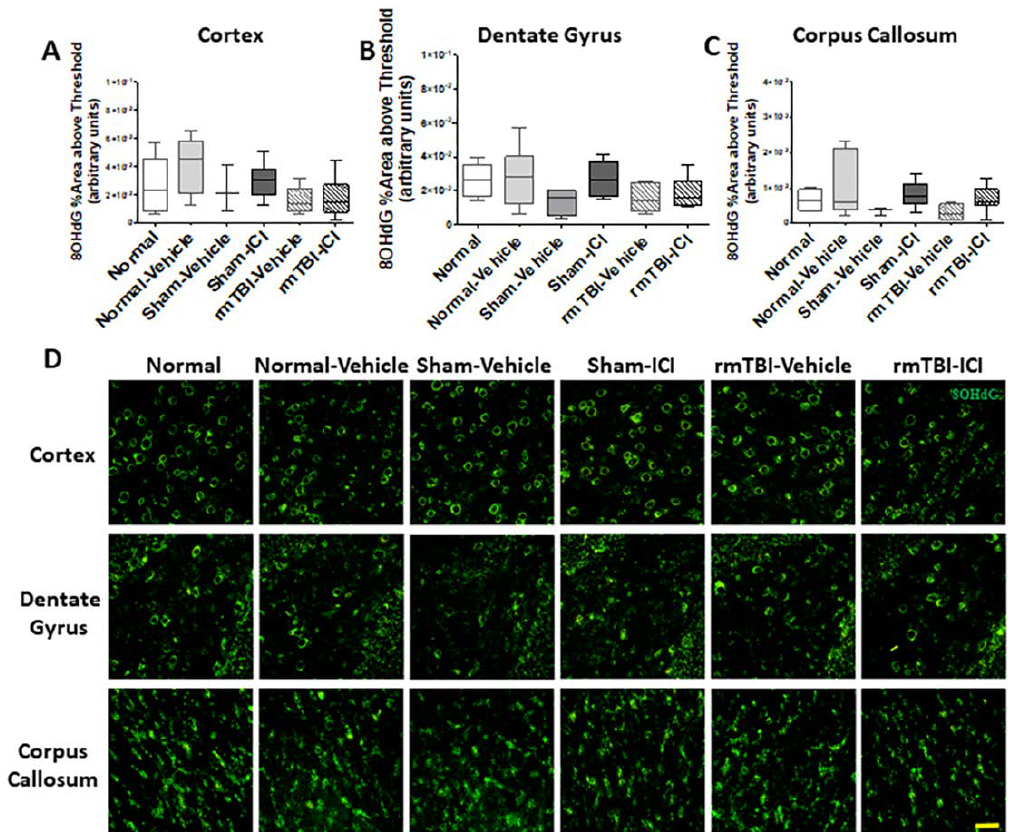
Figure 4. DNA oxidation in the brain on day 11 following mTBI on days 1 and 2. Percentage area above threshold of 8-hydroxy-2′-deoxyguanosine (8OHdG) immunoreactivities are shown as median, interquartile range, and range in the ( A ) middle cortex, the ( B ) hilus of the dentate gyrus, and the ( C ) splenium of the corpus callosum. ( D ) Representative images of 8OHdG (green) immunohistochemical staining indicating DNA oxidation; scale bar = 100 μm.